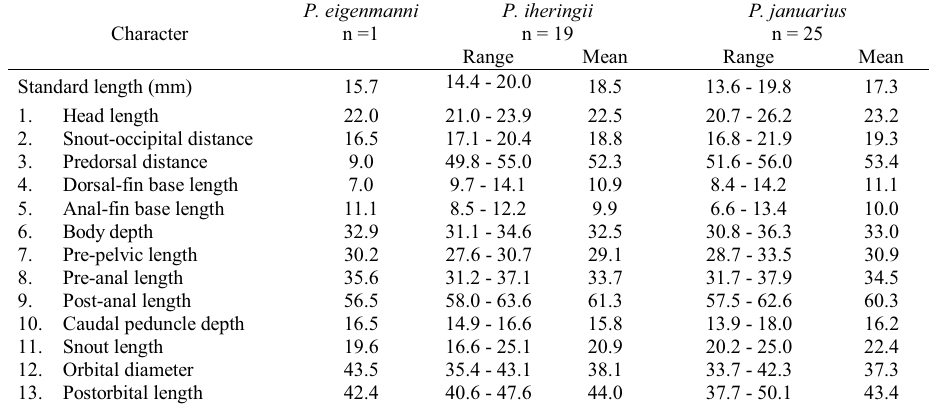
Table 1. Descriptive morphometrics of males of Phalloptychus species. Measurements 1-10 are percents of standard length and measurements 11-13 are percents of head